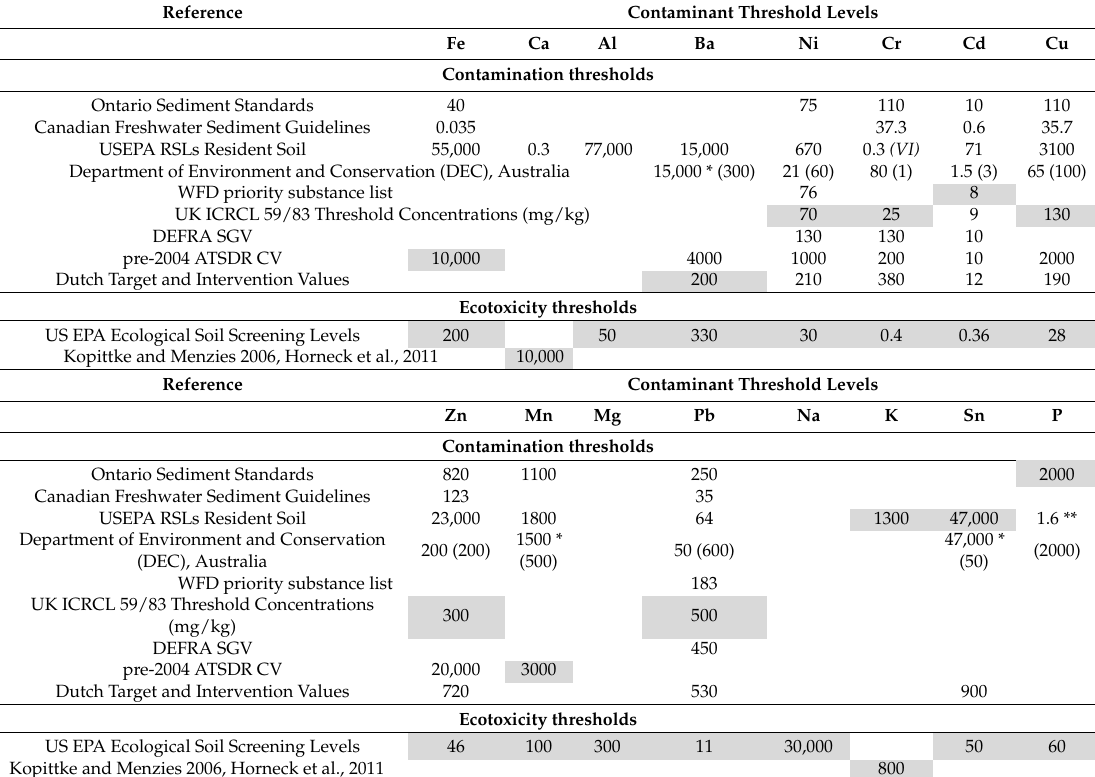
Table 3. Summary of published contaminant threshold